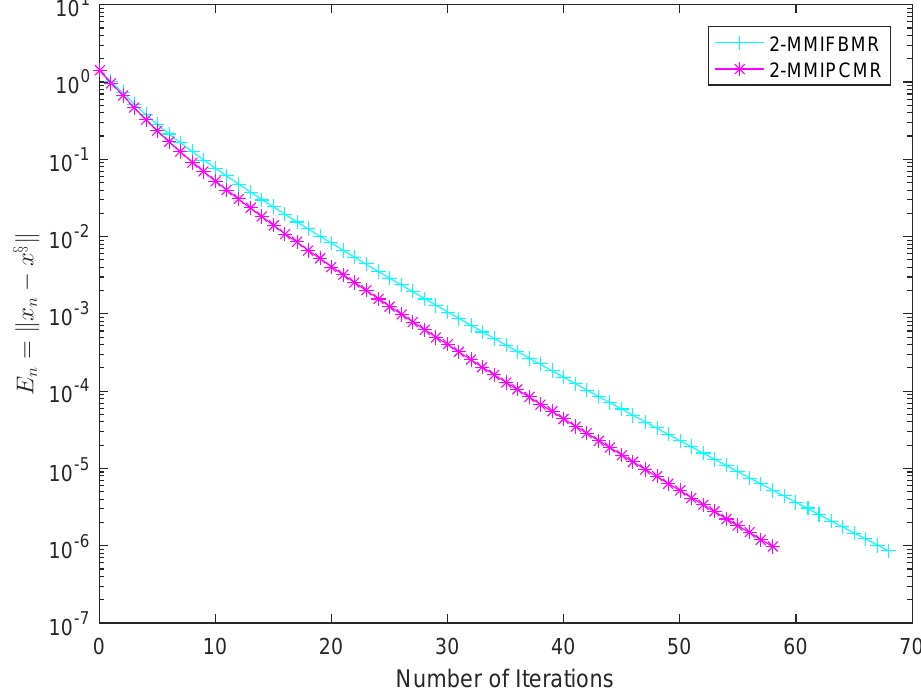
Figure 7. Comparison of 2-MMIFBMR and 2-MMIPCMR in Example